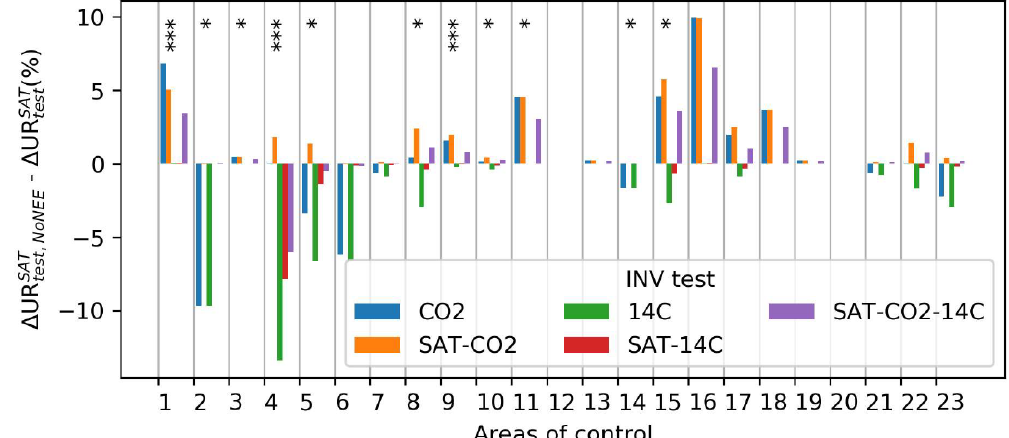
Figure 13. Impact of the NEE on the ground network capability at the top of the satellite observations for each area of control in the main area of interest: differences between (cid:49) UR SAT test on 24h FF regional budgets, with and without NEE. Negative values highlight an increase in the additional observation network potential when NEE is taken into account. Positive values highlight a decrease in the additional observation network potential when NEE is taken into account. High absolute values highlight strong NEE impact. The number of stars indicates the number of stations in each controlled area. The areas are listed in Table 1.